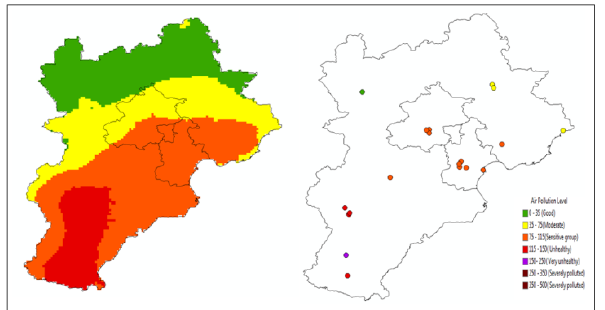
Figure 4. The annual spatial distribution of the air pollution level based on PM 2.5 concentration from the GWR (left) and comparison with air pollution level from ground